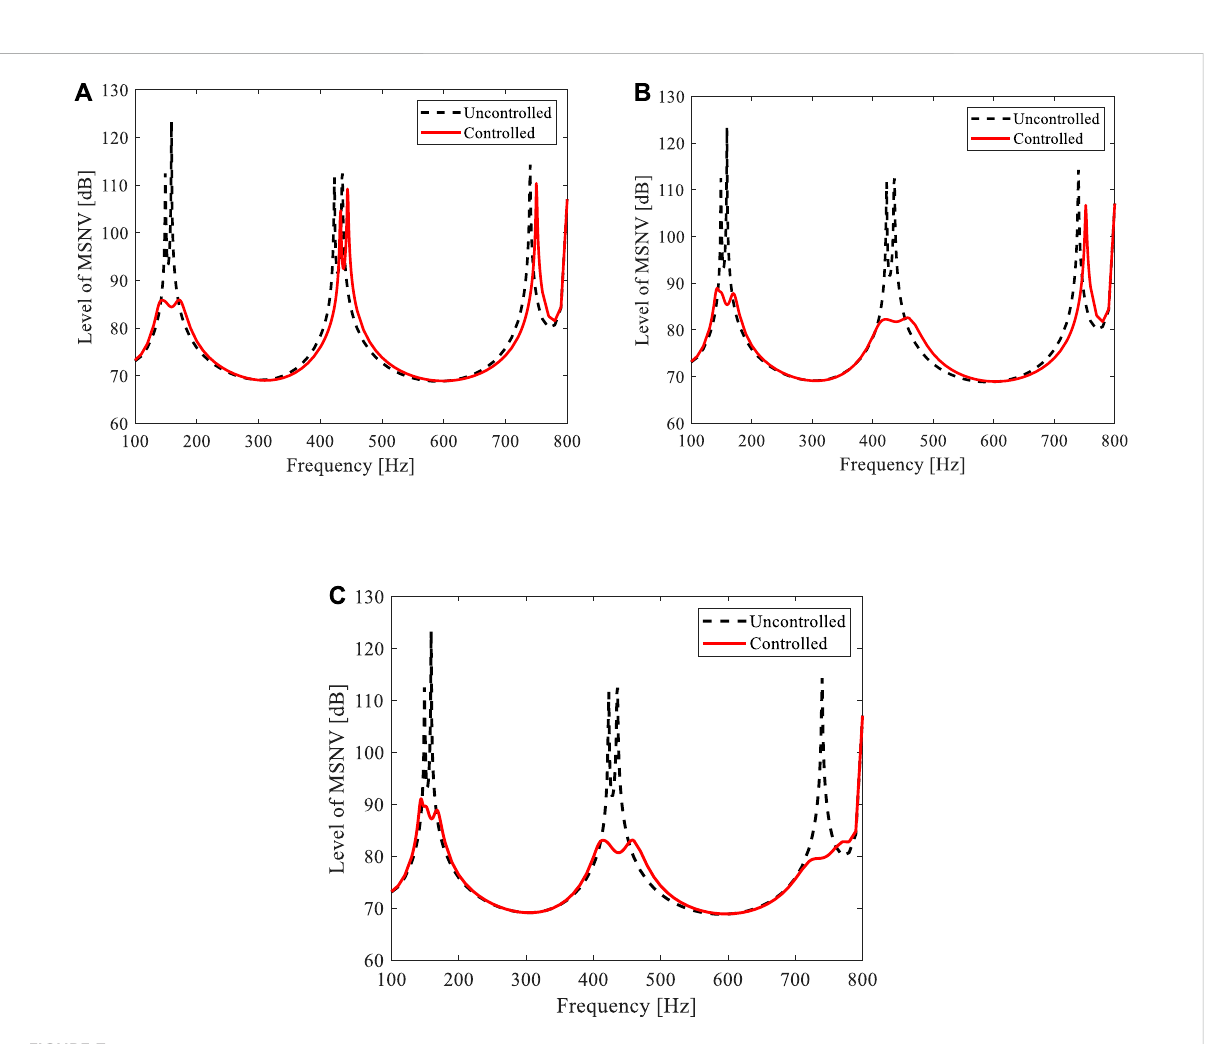
FIGURE 7 Frequency response curves of level of MSNV of the piezoelectric cylindrical meta-shell with different optimized transfer functions. The fi rst (A) two, (B) four, and (C) fi ve modes are targeted,